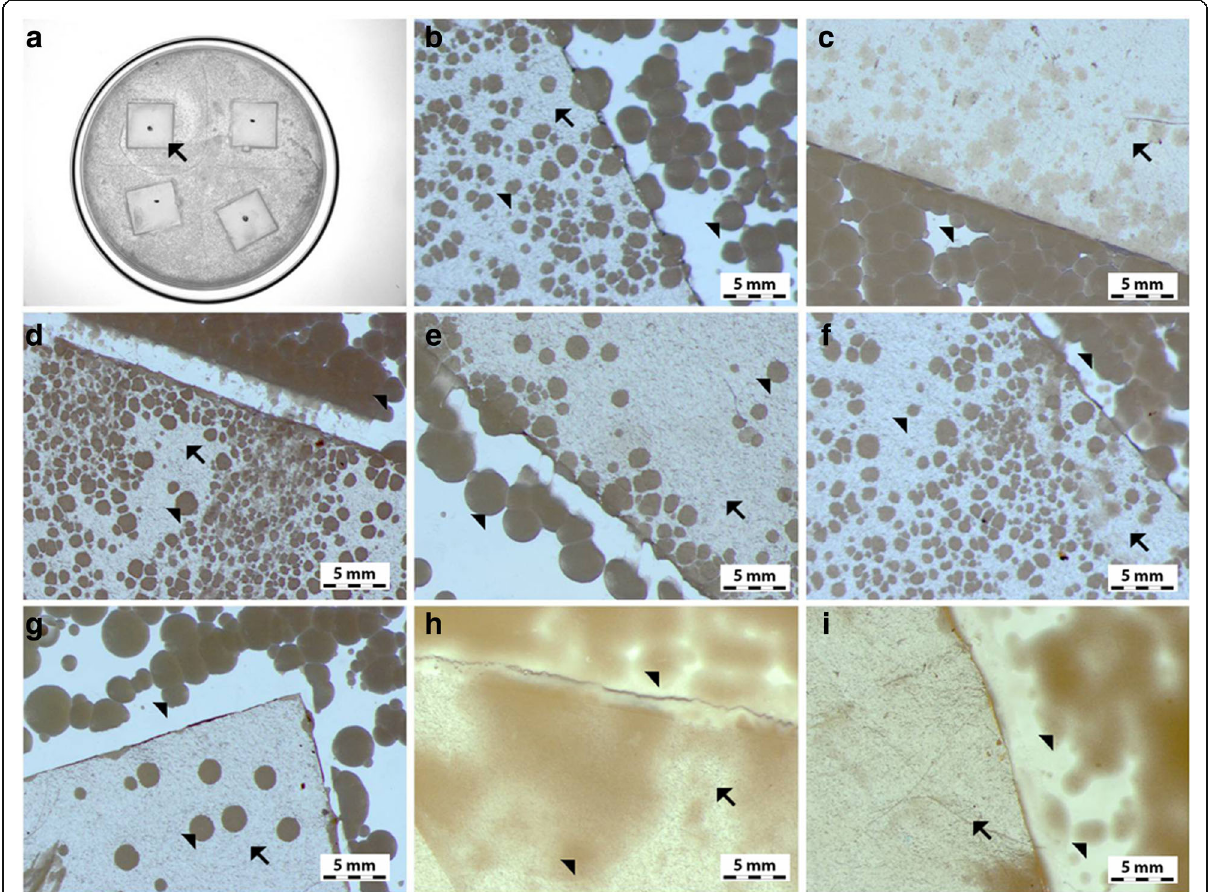
Fig. 9 Antimicrobial properties of GO-Ag coated foils. The growth of E . coli ( b , c ), S . aureus ( c , d ), S . epidermidis ( e , f ), and C . albicans ( g – i ) colonies is reduced after co-incubation with GO-Ag-coated foils at 37 °C for 24 h. a Representative agar plate with GO-Ag-coated foils. Notes: Black arrows point to GO-Ag coated foils; arrowheads point to colonies of